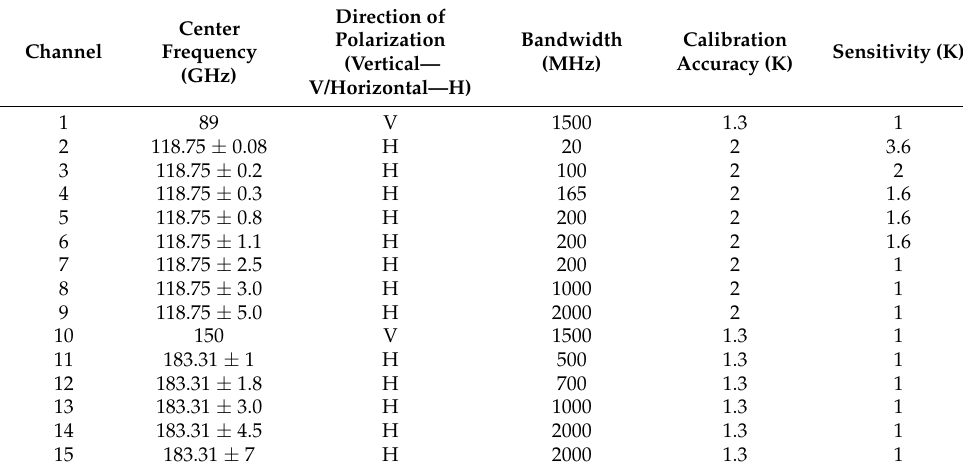
Table 1. Characteristics of MWHS-2 for each